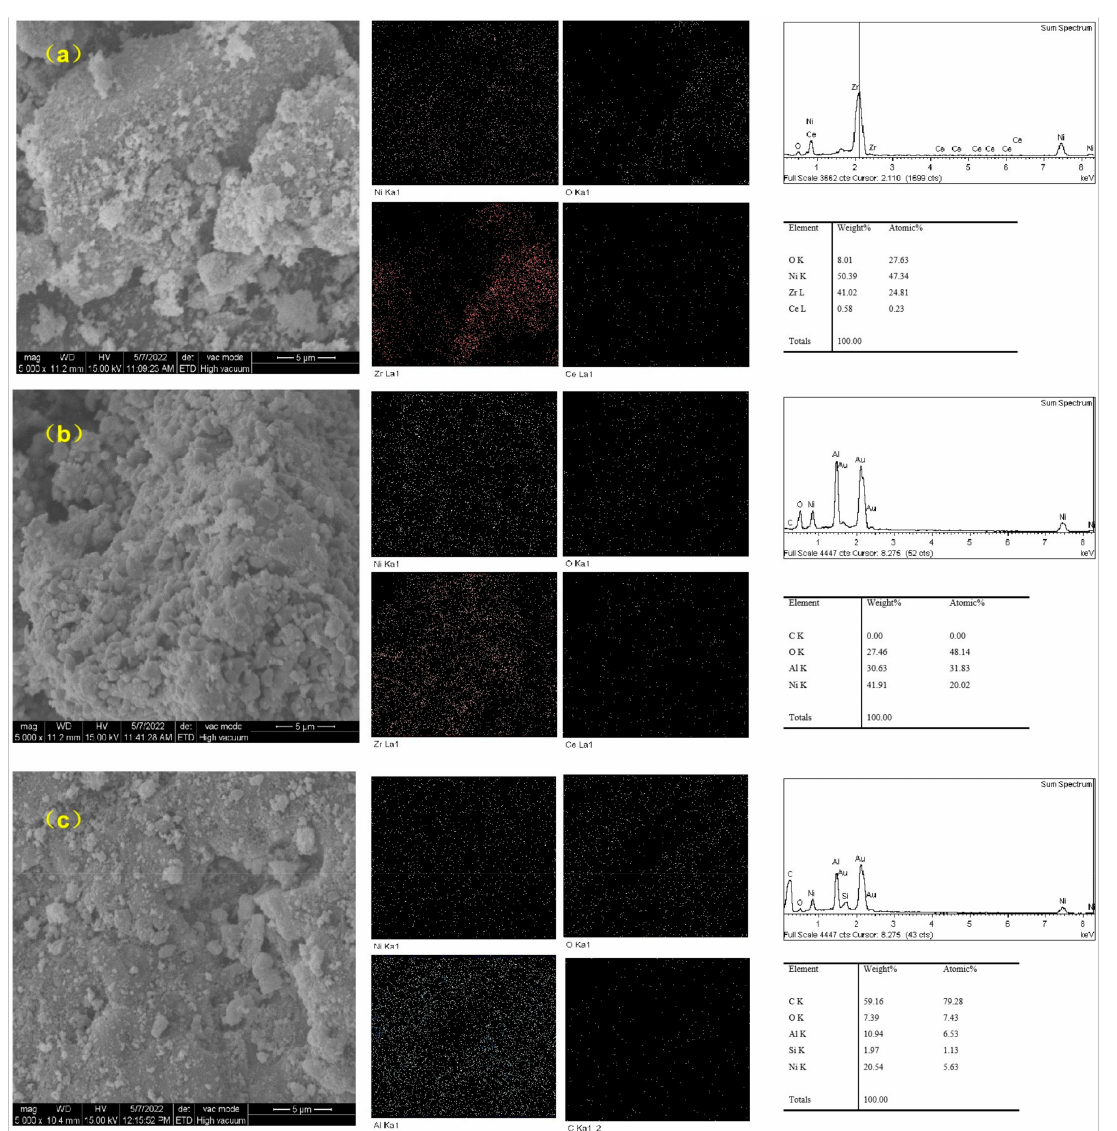
Figure 12. SEM characterization of 25%-Ni commercial catalyst and 25%-Ni synthetic catalyst catalysts before catalytic reforming process ( a , b ) and the commercial catalyst after the process ( c